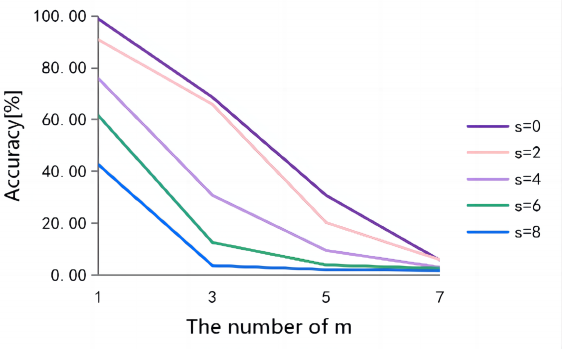
Figure 5. Impact of different s and m values on the classification